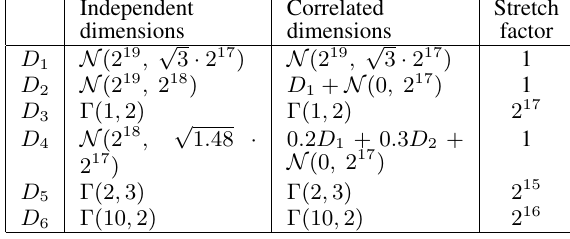
Table 5. Distributions of different dimensions in